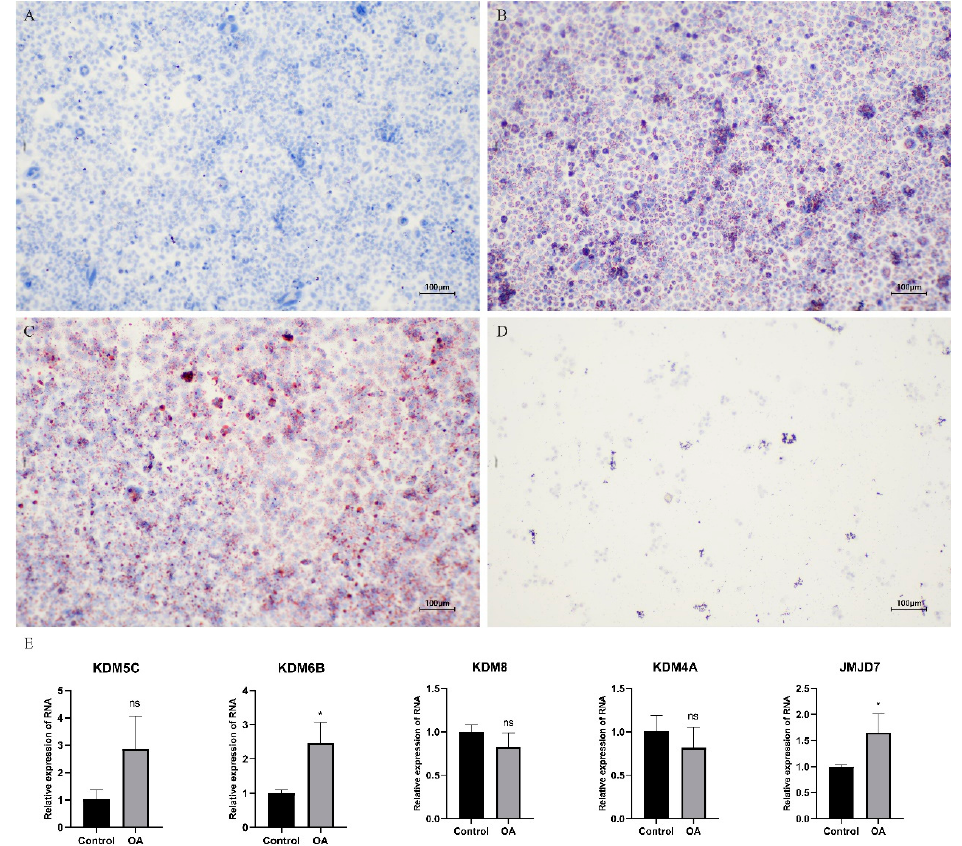
Figure 3. In vitro studies to verify gene expression. ( A ) Not treated with oleic acid. ( B ) L-02 cells treated with 0.5 mM oleic acid (Oil Red O staining). ( C ) L-02 cells treated with 1 mM oleic acid. ( D ) L-02 cells treated with 2 mM oleic acid. ( E ) qRT-PCR to verify gene expression. Abbreviations: qRT-PCR, quantitative real-time polymerase chain reaction; OA, oleic acid; ns, not significant. An asterisk ( *) indicates that the p -value of < 0.05.